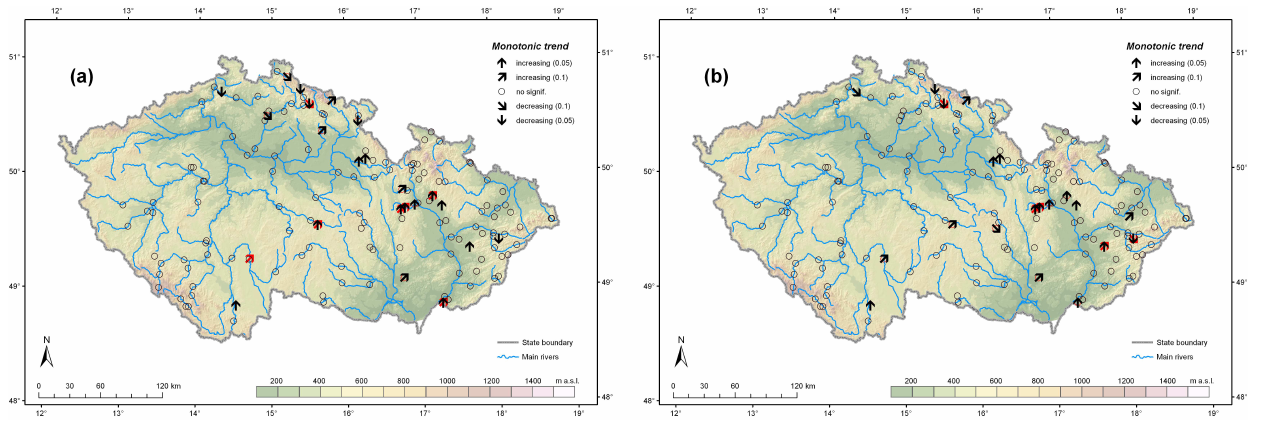
Figure 2. Spatial distribution of trends in annual deficit volumes V 330 (a) and trends in annual numbers of days with discharge under the quantile Q 330d (b) in Czechia during the period 1961–2005 (black symbols – ABBS–MK test, red symbols – BHMLLESS–MK test).